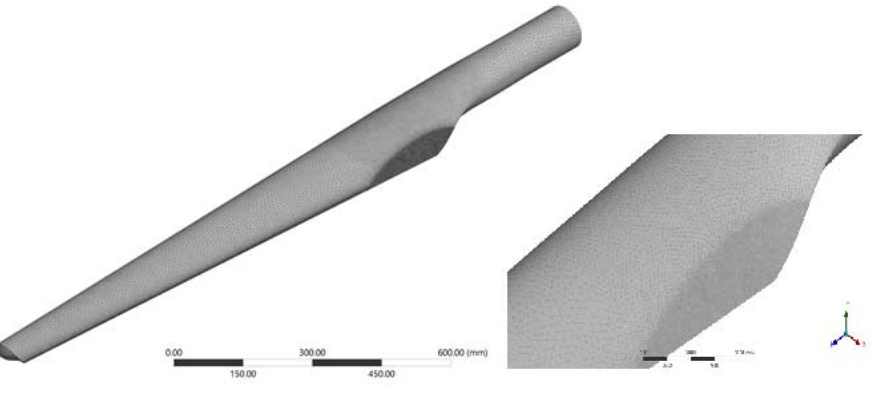
Figure 7. Discretization of the model.